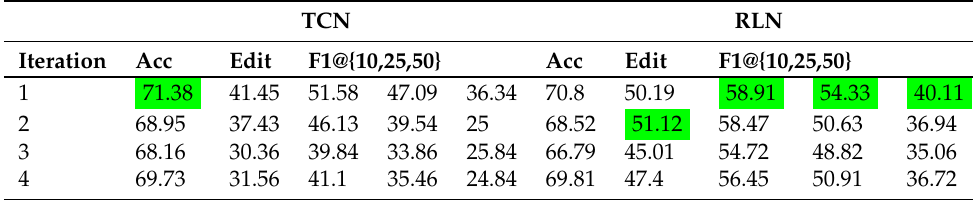
Table 10. RL-SSI in the Fried Egg context.